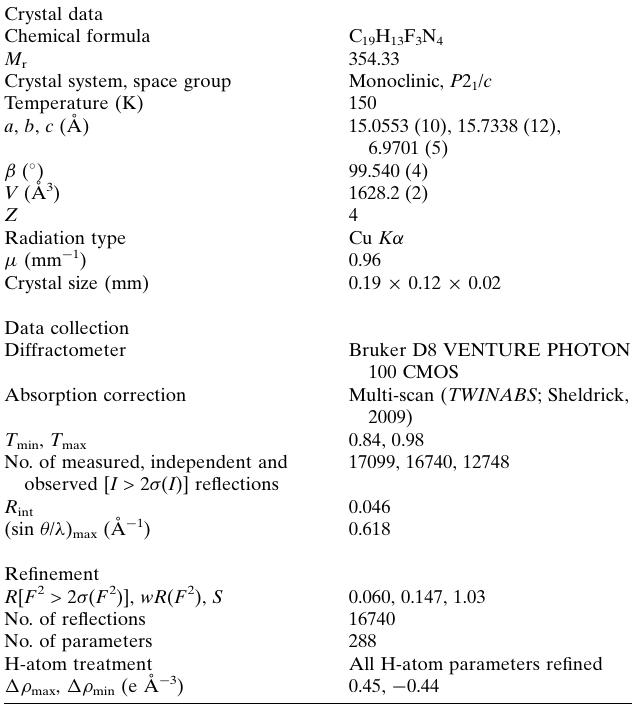
Table 2 Experimental details.